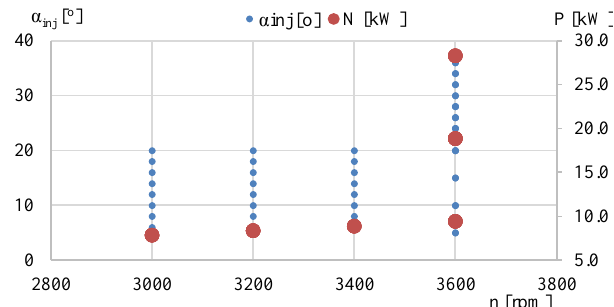
Fig. 4. Location of vibration test points on the PLZ-100